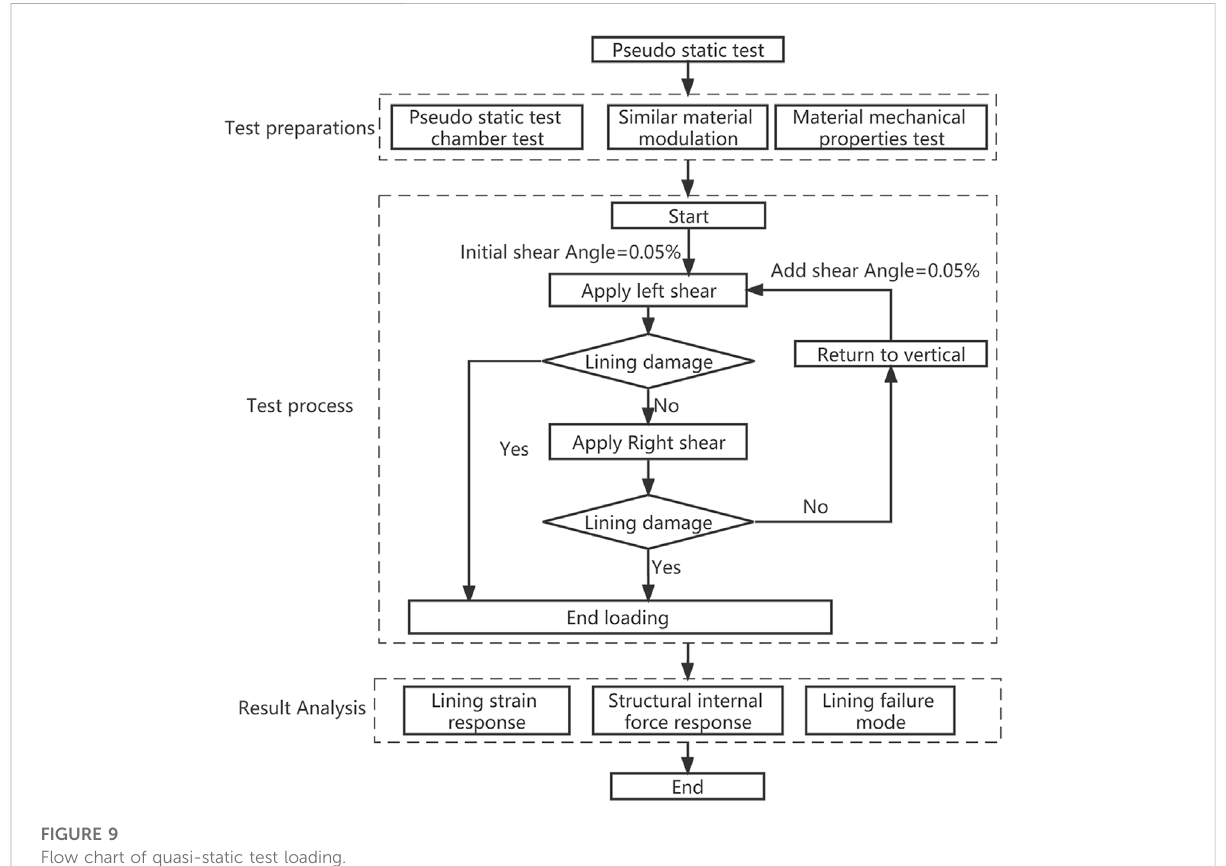
FIGURE 9 Flow chart of quasi-static test loading.